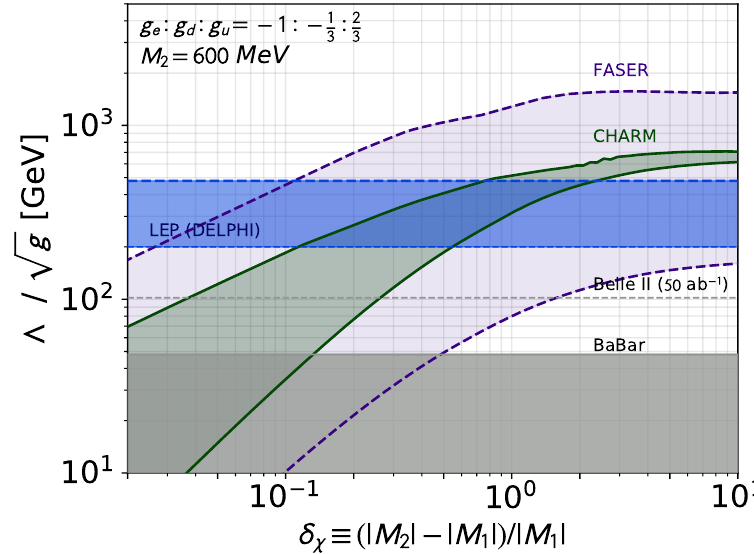
p g as function of (cid:14) (cid:31) as de(cid:12)ned in eq. (2.4).The